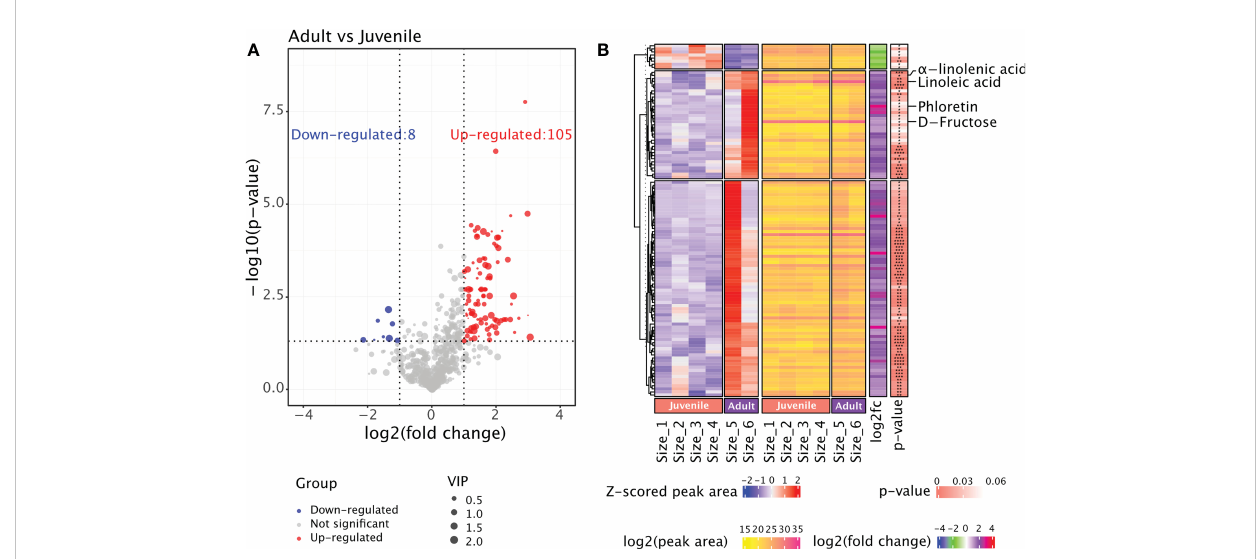
FIGURE 3 Comparative metabolome analysis of metabolites in rhizomes from P. sibiricum at different growth stages. (A) Vocano plot of differentially accumulated metabolites (DAMs) in rhizomes from juvenile and adult P. sibiricum . Dots in blue represent down-regulated metabolites in adult rhizomes. Dots in red represent up-regulated metabolites in adult rhizomes. Dots in grey represent metabolites with similar abundance in juvenile and adult rhizomes. The size of each dot is determined by variable in fl uence on projection (VIP) score of OPLS-DA analysis. (B) Complex heatmaps of DAMs in rhizomes from juvenile and adult P. sibiricum . The fi rst heatmap depicts the Z-scored peak areas of DAMs, and the second heatmap depicts the log2 (peak area) values of DAMs. ****, P ≤ 0.0001; ***, 0.0001 < P ≤ 0.001; **, 0.001 < P ≤ 0.01; *, 0.01 < P <